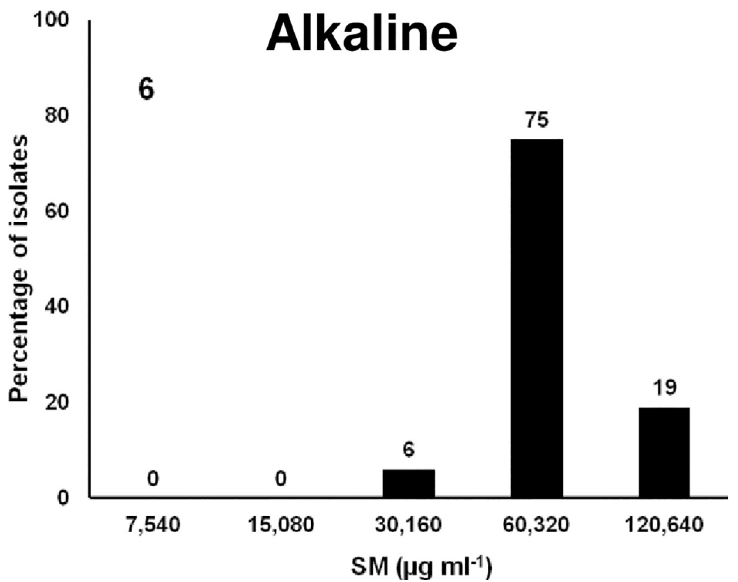
Fig 6. Frequencies of the MICs of 88 MDR Salmonella isolates to alkaline compound, Sodium metasilicate, SM. X- axis is the 2-fold increase of biocide concentration; y-axis is percentage of isolates susceptible at each concentration of